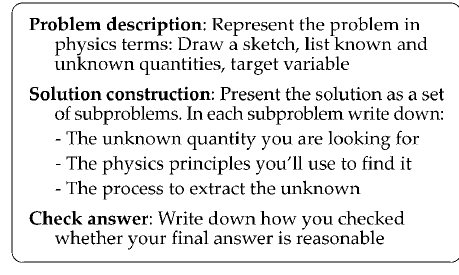
FIG. 1. Guidelines for presenting a problem solution according to a problem-solving strategy.